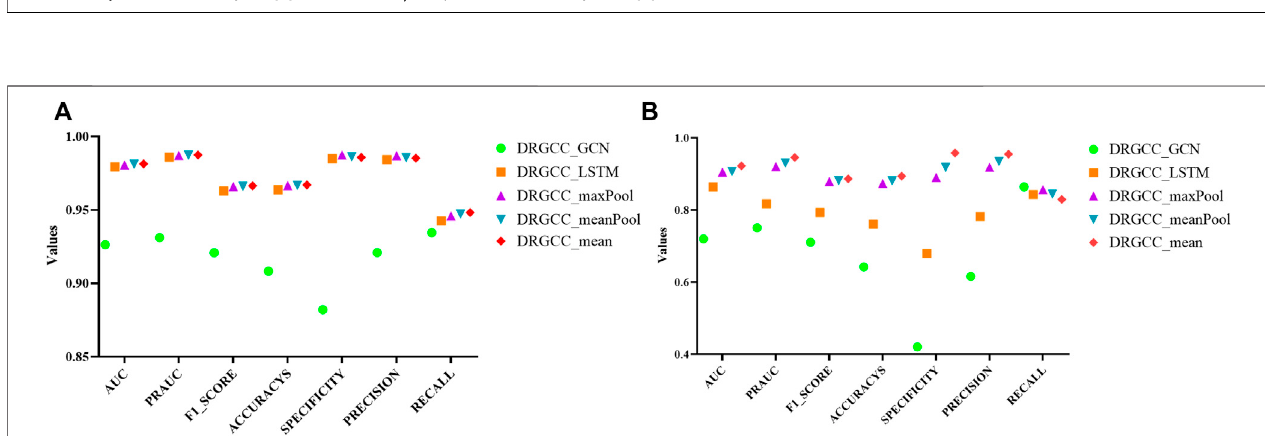
FIGURE 3 | Impact of different aggregation methods on performance. (A) Performance of different aggregation methods on the CTD dataset; (B) Performance of different aggregation methods on the HDVD dataset.